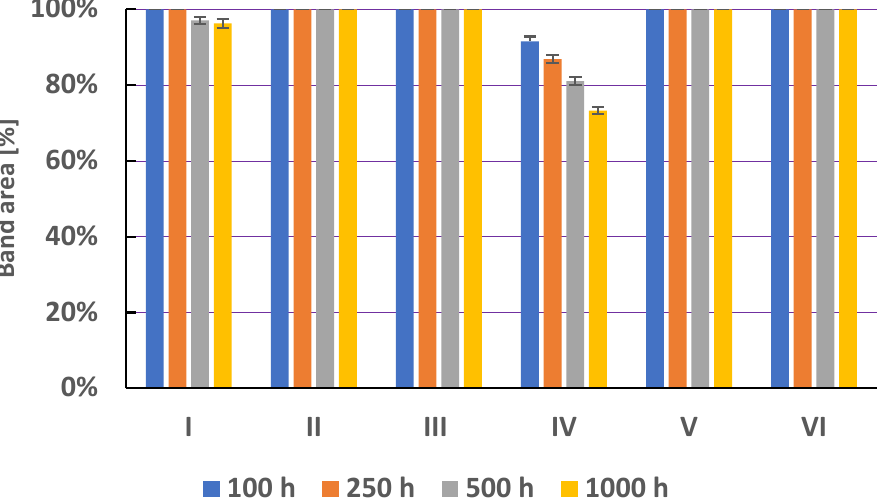
Figure 8. The comparison of means area ( ± SD) (in %) of chromatographic bands obtained from secnidazole (S) in different solvents (I—in water at pH = 2.62; II—in water at pH = 5.56; III—in water at pH = 8.21; IV—in hydrogen peroxide (3%); V—in physiological salt (0.9% NaCl); and VI—in methanol) which were heated at 40 °C for 100, 250, 500, and 1000 h, where SD is the standard deviation.